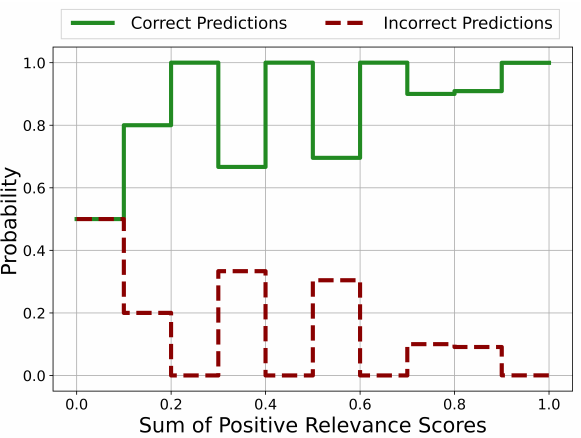
Figure 6. Probability distribution of the sum of positive Relevance scores in the case of correct (green solid line) and incorrect (red dashed line) predictions on the test set. Potentially unreliable predictions occur in the ranges [0.0, 0.2], [0.3, 0.4], [0.5, 0.6] and [0.7,